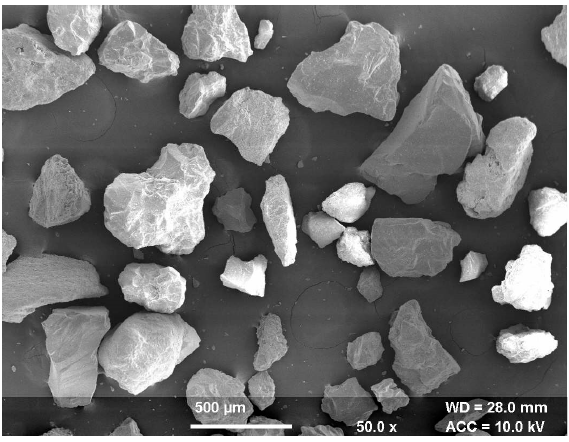
Figure 3. SEM of river sand particles.